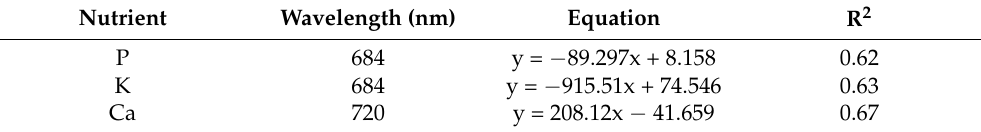
Table 2. Models for estimating leaf nutrient content using a single spectral band.